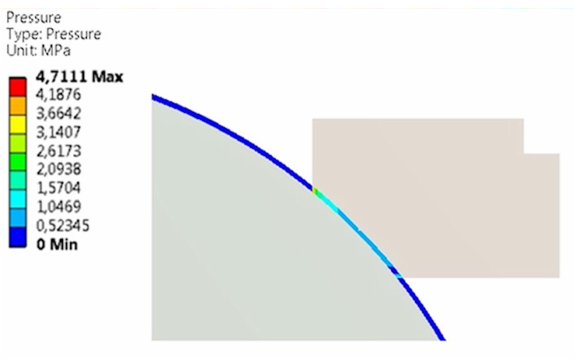
Figure 6: The contact stress distribution between the ball and seal variant